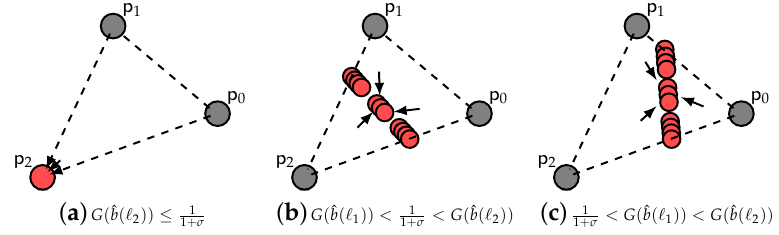
Figure 2. Dynamics for a linear f ( · ) , where (cid:96) c ≥ (cid:96) d . Set of strategies S = { 0,1,2 }